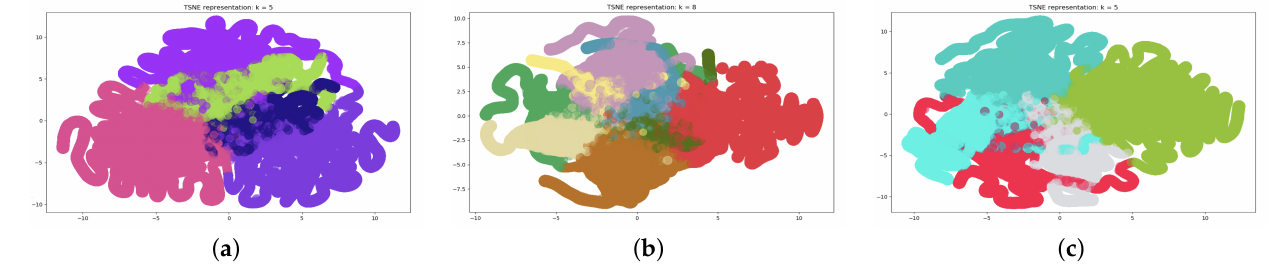
Figure 6. The best partitioning t-sne maps for all the weighting strategies for the Luggage dataset are displayed above. ( a ) Dataset D8. t-SNE representation. Bool-IDF weighting schema K = 5. ( b ) Dataset D8. t-SNE representation. LogTF-IDF weighting schema K = 8. ( c ) Dataset D8. t-SNE representation. TF-IDF weighting schema K = 5.